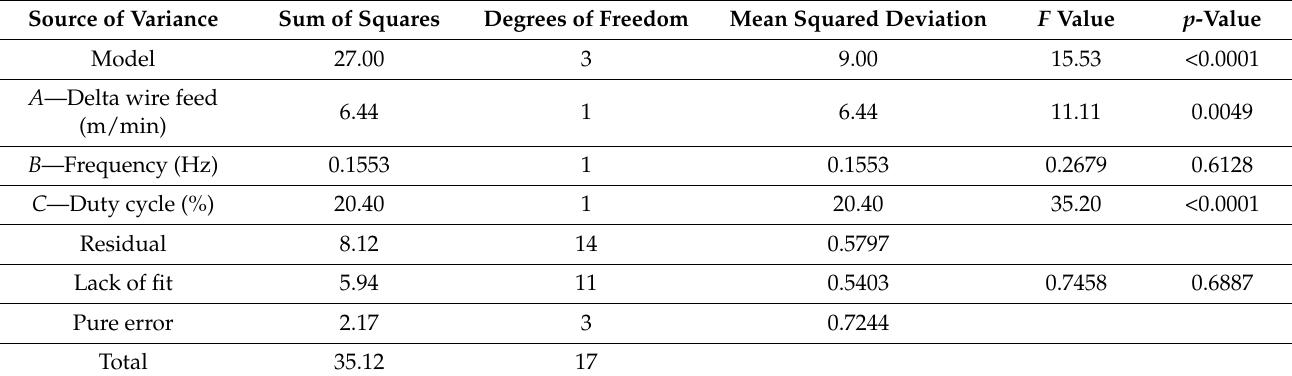
Table 11. Analysis of variance for the regression model–weld